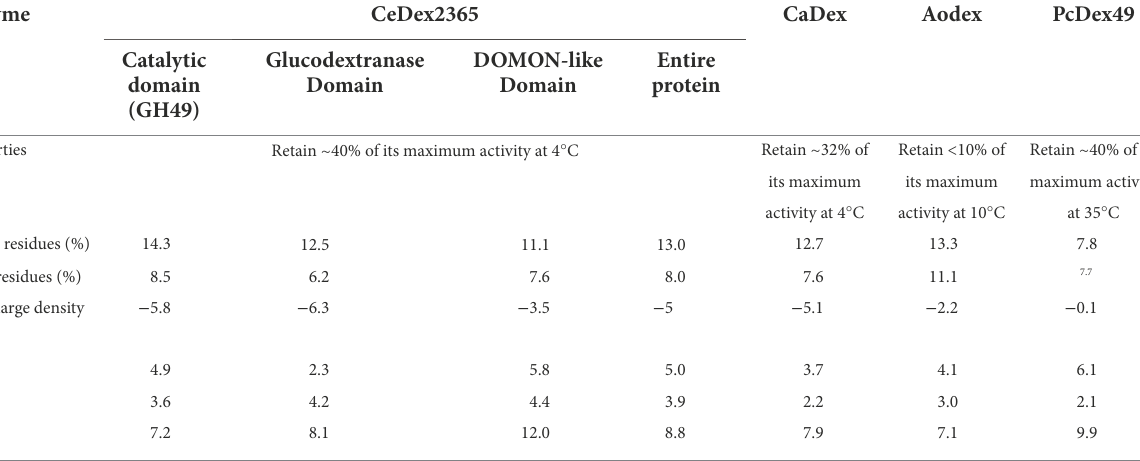
TABLE 4 Comparison of the properties and frequencies of charged amino acid residues for different domains in CeDex2365 and other dextranases. Enzyme